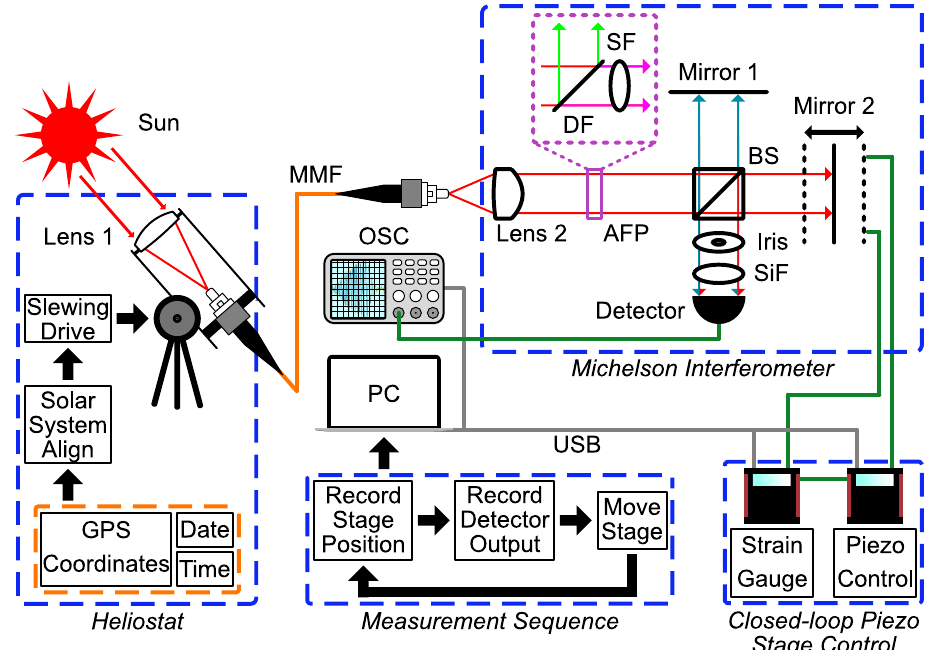
Figure 2. Experimental set-up. Sunlight is captured by a heliostat, consisting of a free-space fibre coupling cage system controlled by a slewing drive with solar system alignment, and coupled into a multimode fibre (MMF). At the MMF output, the sunlight is collimated and is passed into the Michelson Interferometer, where it is split by a non-polarizing 50:50 beamsplitter (BS). Mirror 2 is mounted on a piezo-actuated translation stage with sub-nanometer resolution. The piezo stage is controlled by a strain gauge and piezo controller in closed-loop operation mode. Upon recombination, the light beams are sent through a silicon response-flattening filter (SiF) before being detected by the silicon photodetector. The output of the detector is visualized on an oscilloscope (OSC). Piezo stage translation, stage position readout, and oscilloscope readout are automated by a Matlab measurement sequence running on a PC connected via USB. The analogous filter package (AFP), represented by the purple dashed inset, is removable and was not present for the instrument-filtered data collection. When present, sunlight incident on the dichroic filter (DF) is split based on wavelength: green light is reflected and blocked, magenta light is transmitted and sent to through a 700 nm shortpass filter (SF) before passing to the rest of the Michelson